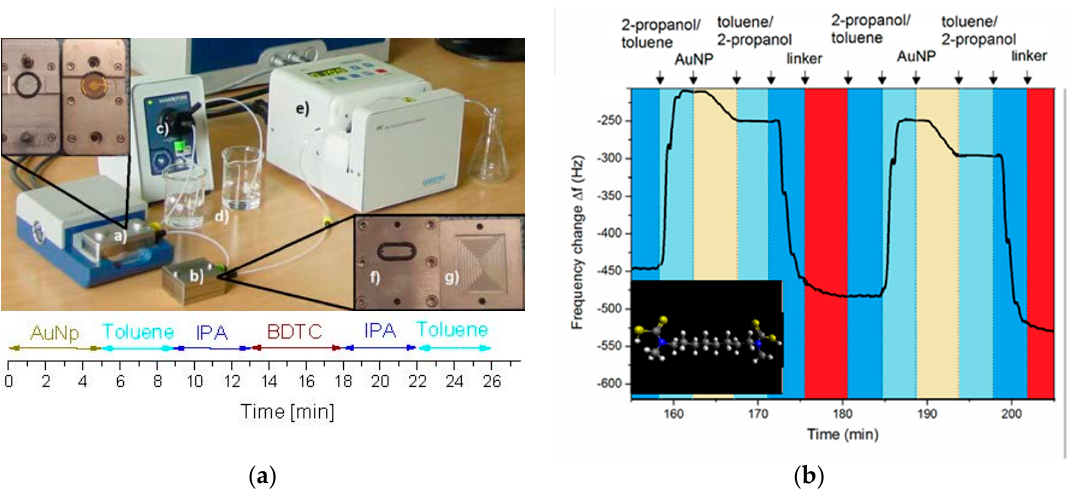
Figure 1. Layer-by-Layer self-assembly process: ( a ) automated setup for the nanocomposite preparation as described previously [3]. It includes also the used assembly cycle at the bottom; ( b ) detailed view of the frequency shift over time during two deposition cycles for the composite. The respective injection steps for the nanoparticles, the BDTC solution, and the solvent rinses are colored (light blue, toluene; dark blue, 2-propanol; yellow, gold nanoparticles in toluene; red, linker in 2-propanol). The inset shows the used